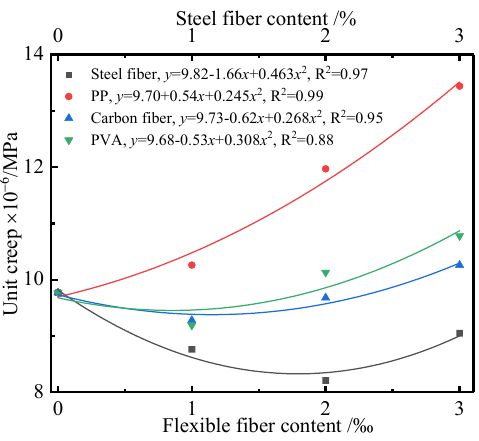
Figure 14. Unit creep curves of the UHPC cured for 90 d with the fibers content.